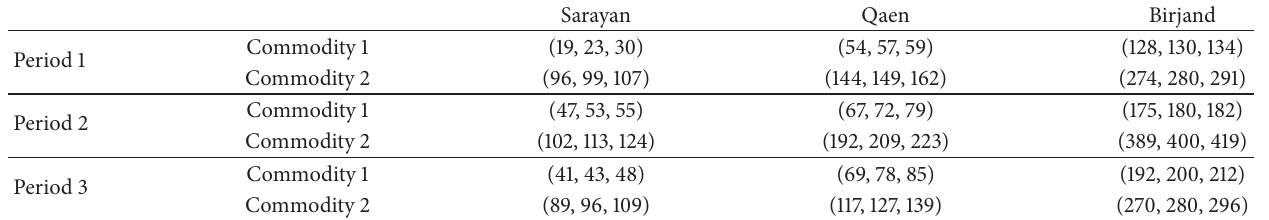
Table 10: The amount of inventory has been estimated in the candidate areas for the establishment of distribution centers ( ∗